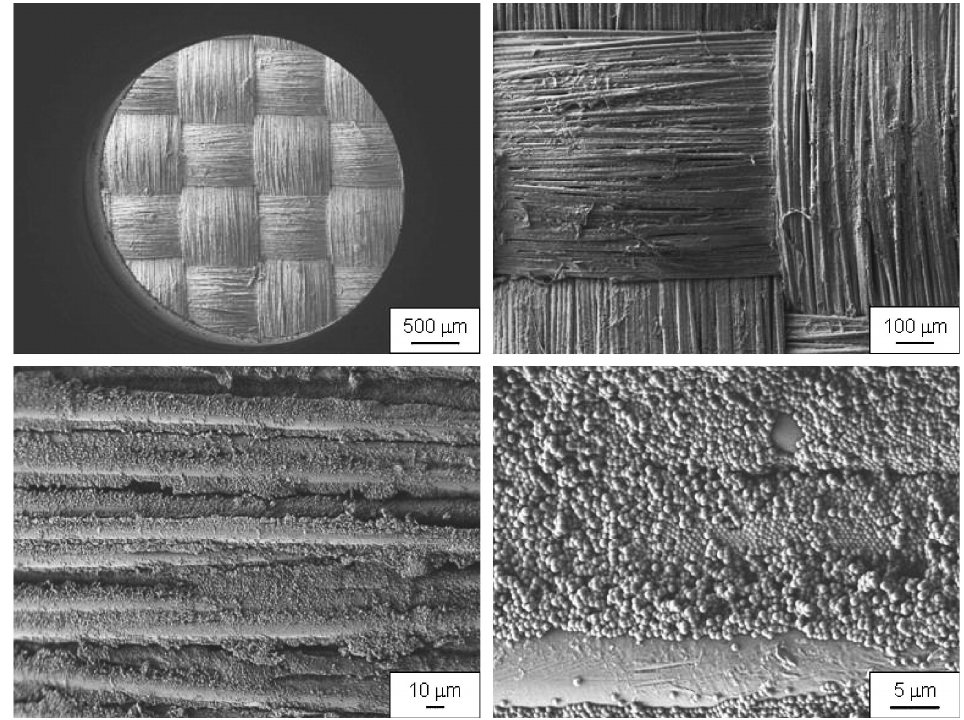
Figure 11. SEM images of undamaged Kevlar coated with STFs in different magnifications. Reprinted from [88], Copyright (2007), with permission from Elsevier.